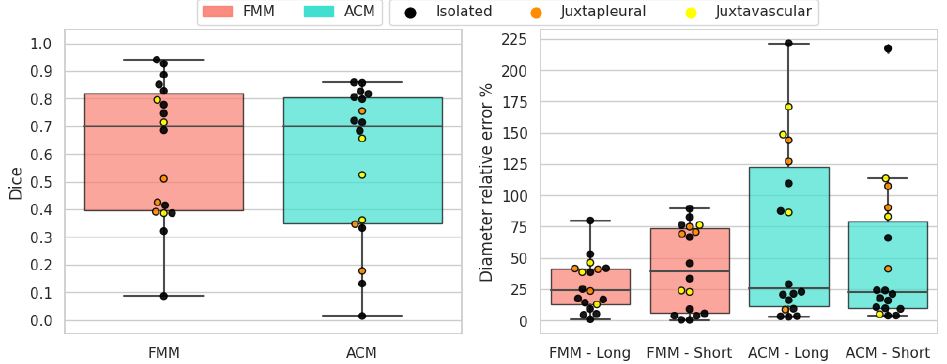
Figure 16. Cavitary nodules’ objective evaluation results as boxplots, overlayed with the values of individual cases divided into subcategories.